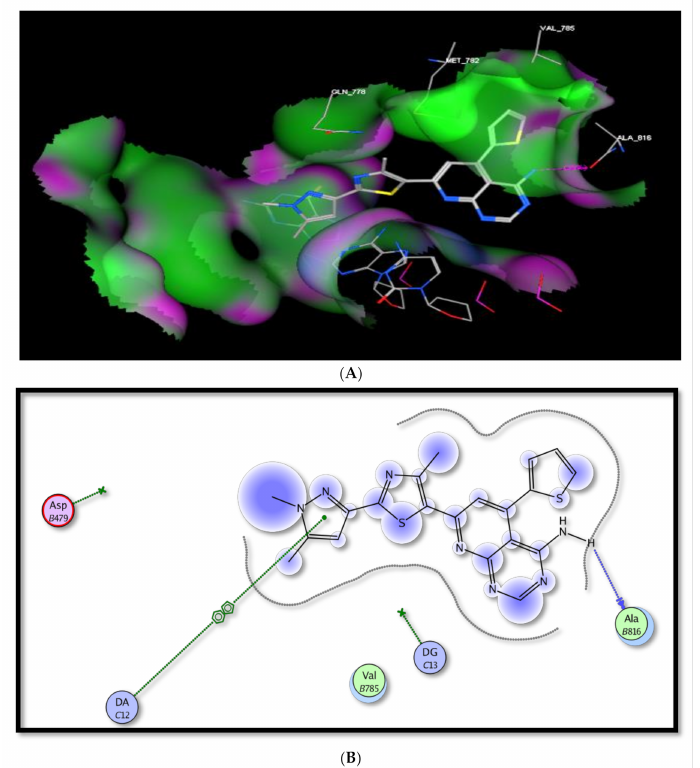
Figure 10. The suggested binding mode of compound 11 within topoisomerase II. ( A ) 3D binding mode within the active site. ( B ) 2D binding mode within topoisomerase II.